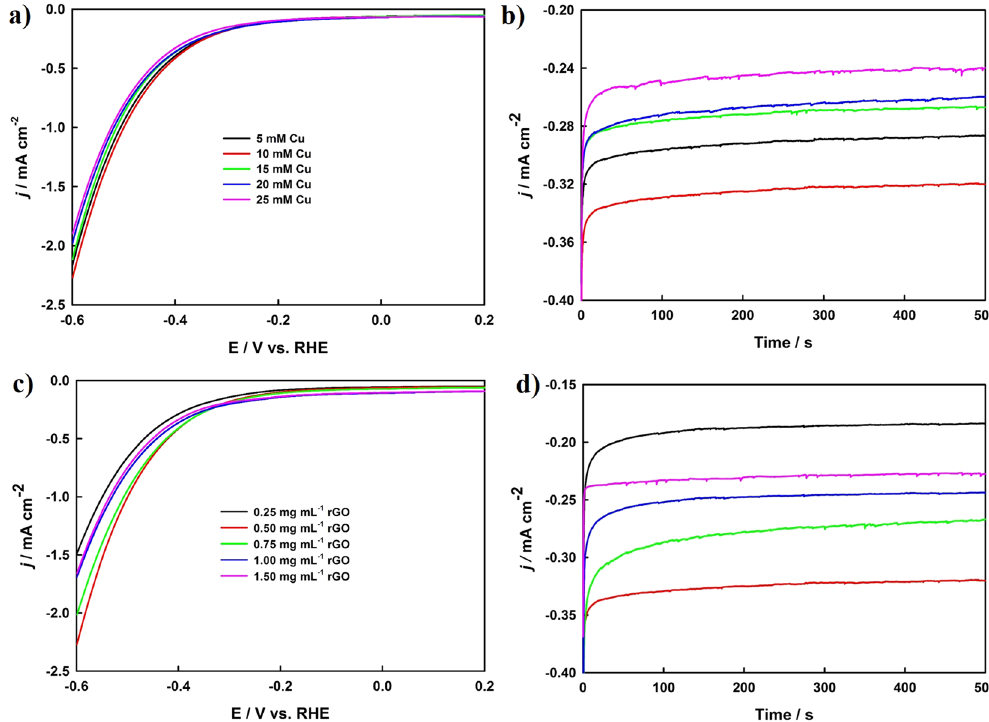
Figure 3. LSV curves ( a ) and CA plots ( b ) of the Cu-rGO nanocomposite electrodes prepared with a constant GO concentration (0.5 mg mL − 1 ) while the concentration of the Cu precursor was changed from 5 to 25 mM as listed in Fig. 3a. LSV curves ( c ) and CA plots ( d ) for the optimization of the GO concentration while the concentration of the Cu precursor was maintained at 10